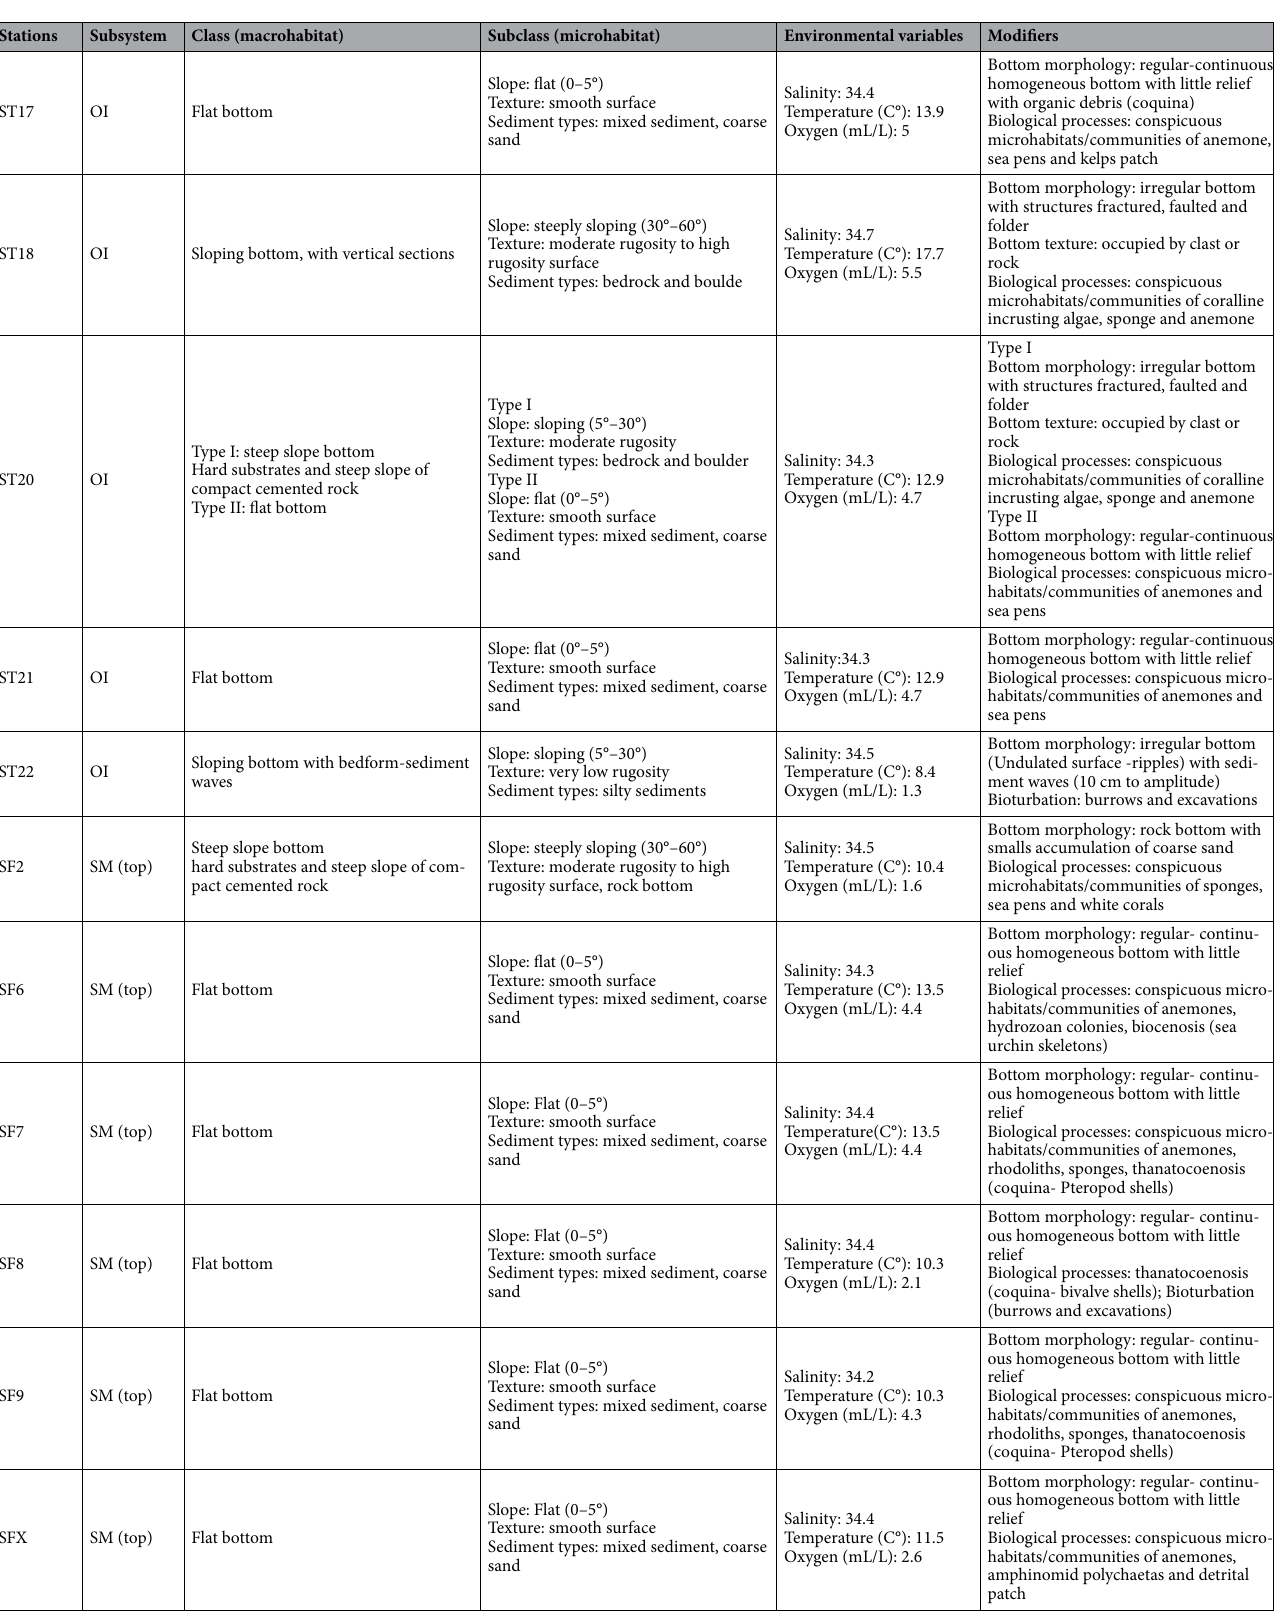
Table 1. Description of benthic habitats of the oceanic islands (Desventuradas). Classification follows Greene et al. 1 and Greene et al. 32 . Subsystem OI = oceanic islands (upper slope) and SM = seamounts